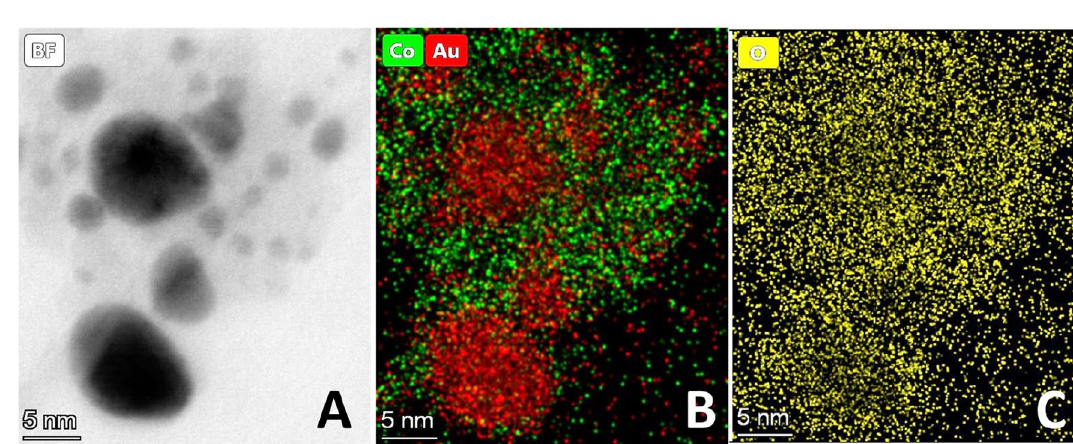
Figure 8. Bright field STEM image of Au/Co particles (generated at 5.4 Ω circuit resistance without heat treatment) ( A ), and SEM–EDS elemental maps of the same area showing the distribution of Co and Au ( B ), and O ( C ),